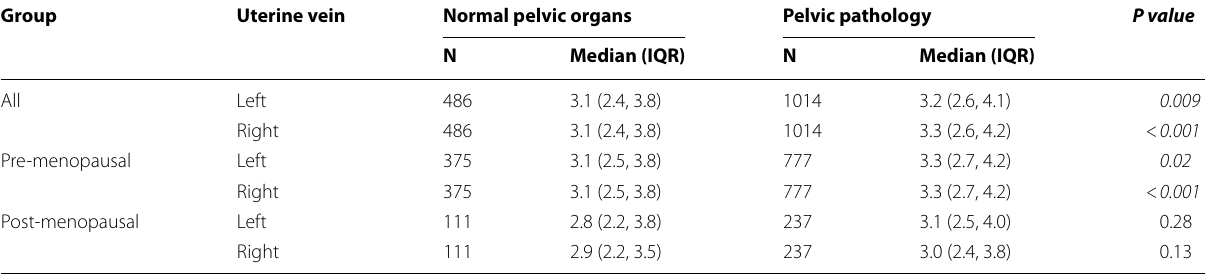
Table 4 Comparisons of uterine vein diameters between women with normal pelvic organs and with pelvic pathology ( N =